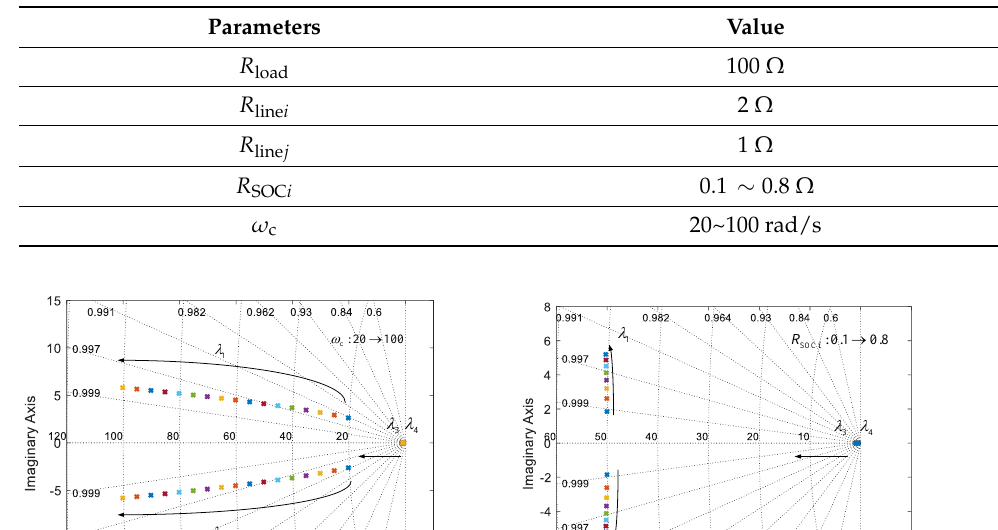
Table 1. Parameters related to stability analysis.